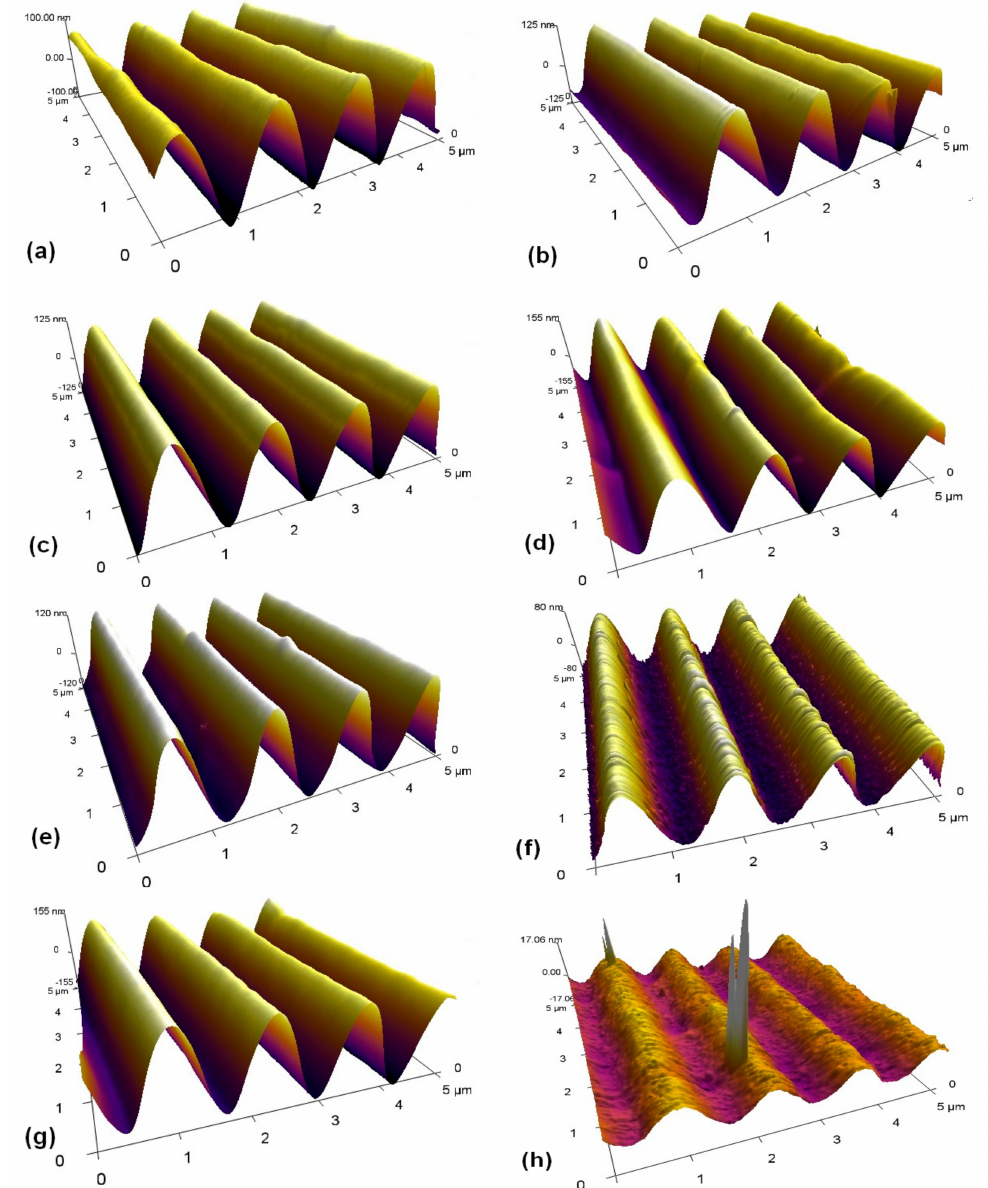
Figure 6. Three-dimensional AFM images of the surface relief gratings, formed at recording angle 2 θ = 20 ◦ for the following nanoparticles concentrations: ( a ) C = 0%, ( b ) C = 0.5%, ( c ) C = 1%, ( d ) C = 2%, ( e ) C = 5%, ( f ) C = 7.5%, ( g ) C = 10%, and ( h ) C =